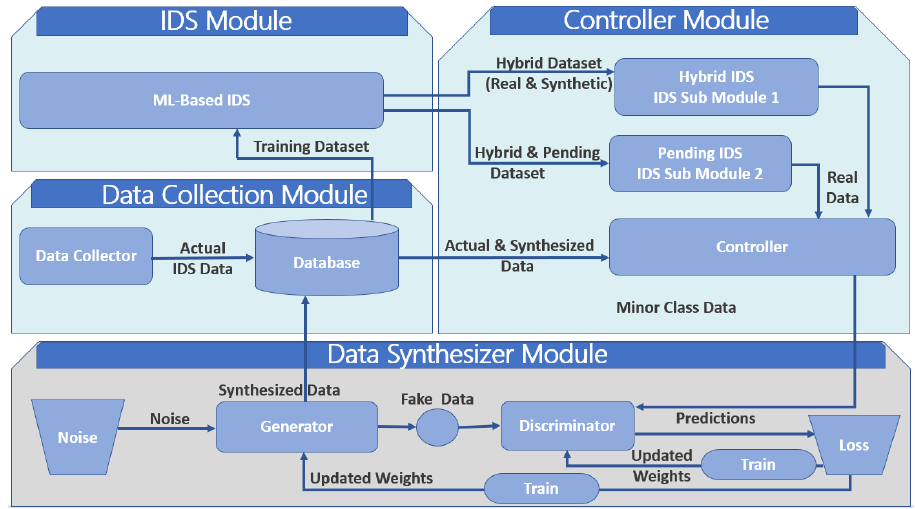
Figure 1. G-IDS Framework Block diagram (Recreated with permission from ref. [28]. Copyright 2022 Mohammad Ashiqur